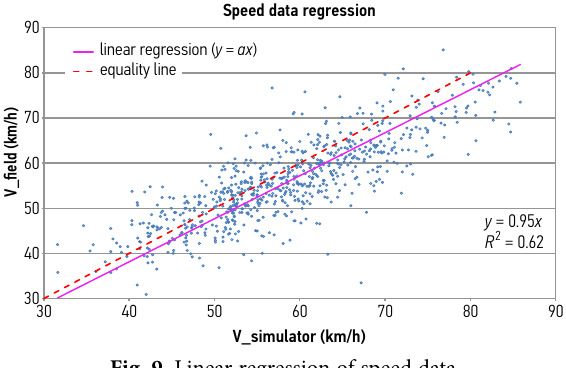
Fig. 9. Linear regression of speed data